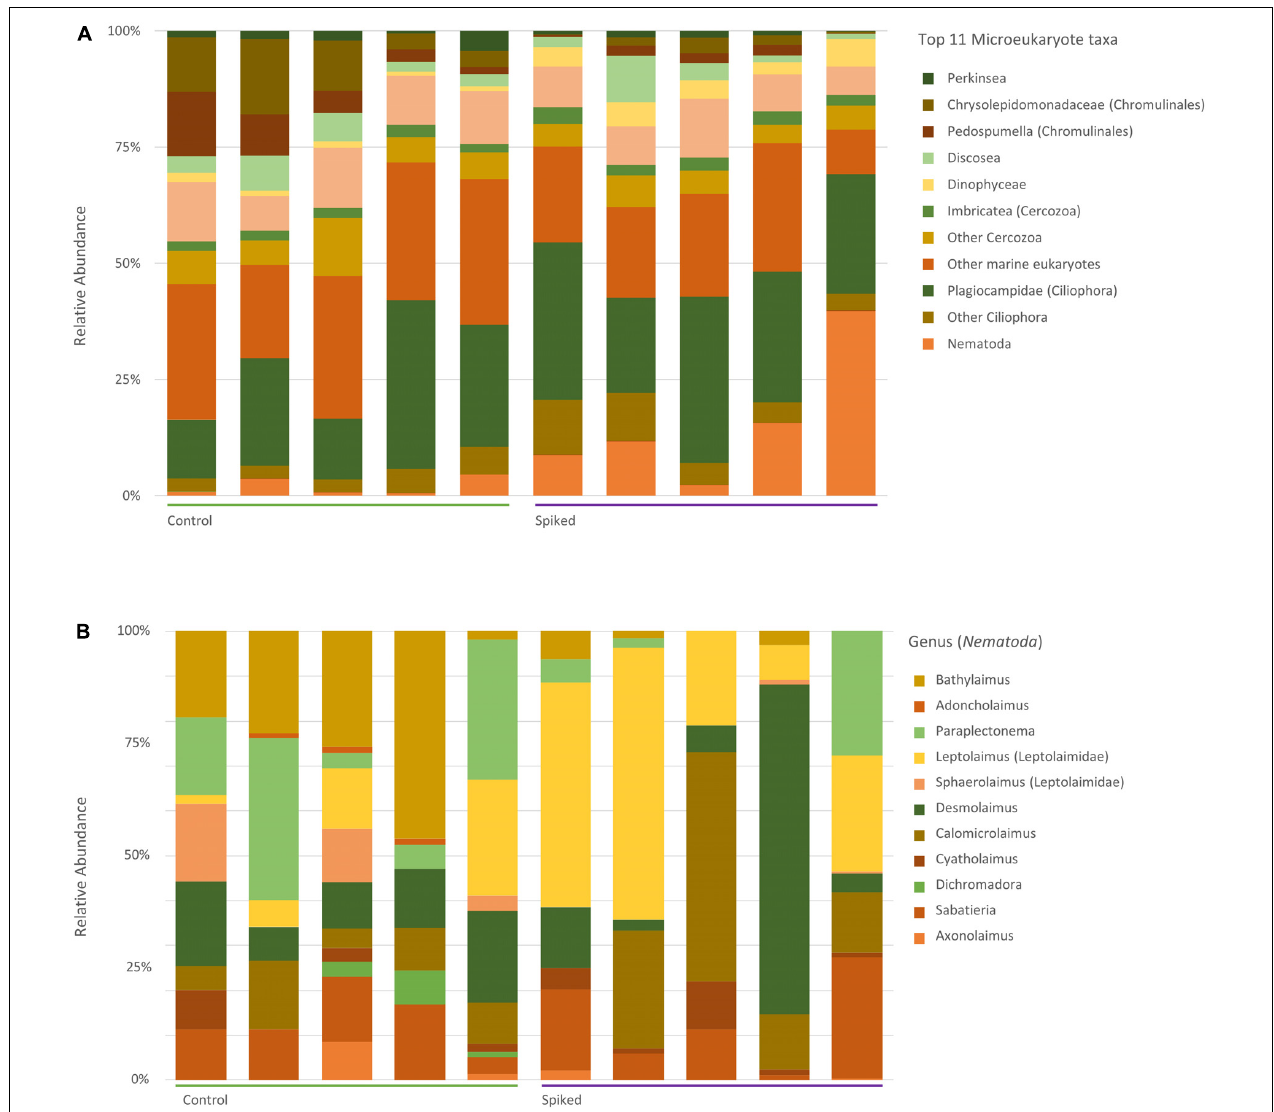
FIGURE 5 | Relative abundance of the top 11 most common taxa reported for the 18S rRNA (A) and the most common genera amongst nematodes (B)